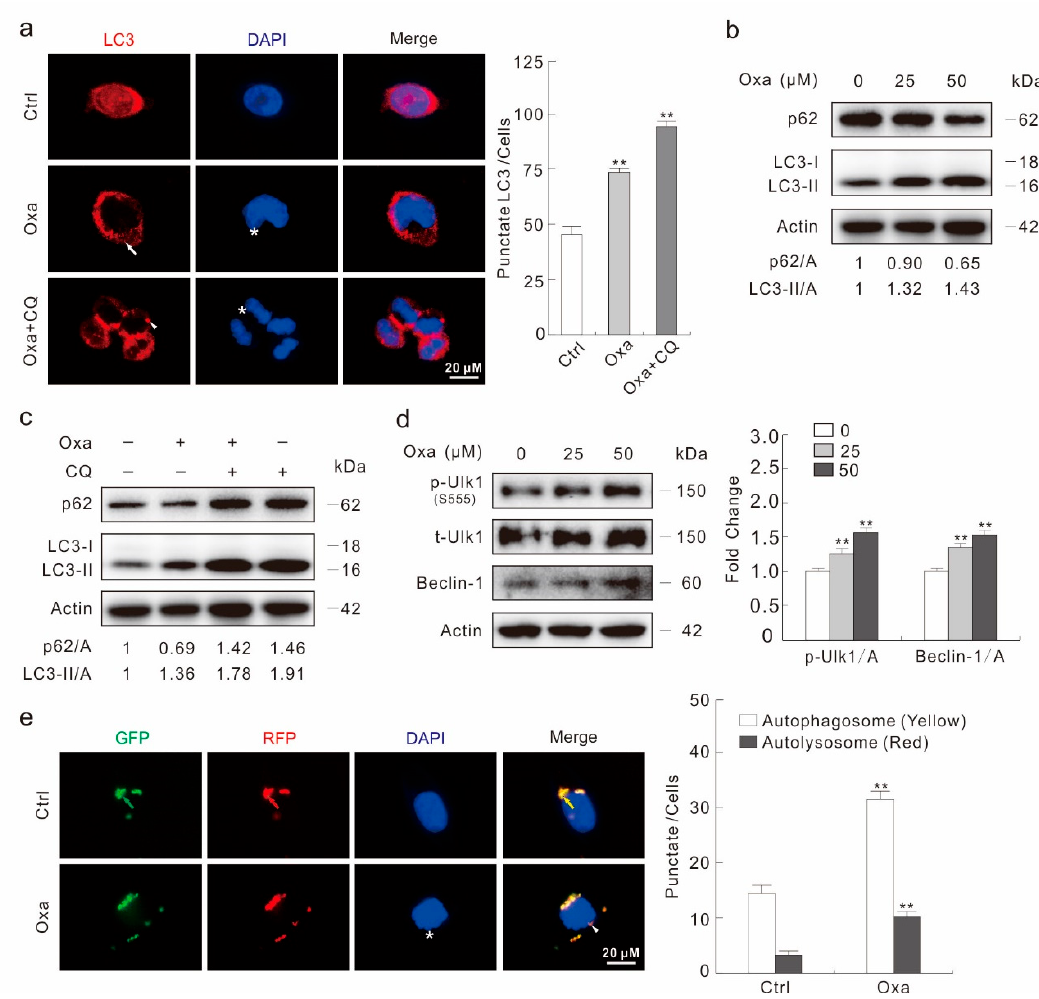
Figure 2. Oxa induces autophagy in SW480 cells. ( a ) Immunofluorescence using the antibody of LC3 was performed in SW480 cells following treatment with Oxa (25 μ M hereafter, or otherwise indicated) in the presence or absence of CQ (20 μ M hereafter) for 2 h (1000 magnification). The numbers of the punctate LC3 in each cell were counted, and at least 30 cells were included for each group. ( b – d ) Cells were treated with indicated dose of Oxa for 2 h in the presence or absence of CQ. Cell lysates were subjected to immunoblotting with the antibodies indicated. ( e ) After transfection with GFP-RFP-LC3 plasmids for 24 h and split onto coverslips then cultured overnight, SW480 cells were treated with or without Oxa for 2 h (1000 magnification). The number of the yellow and red dots in each cell was counted, and at least 20 cells were included for each group. Data represent three independent experiments. ** p < 0.01 vs. control.